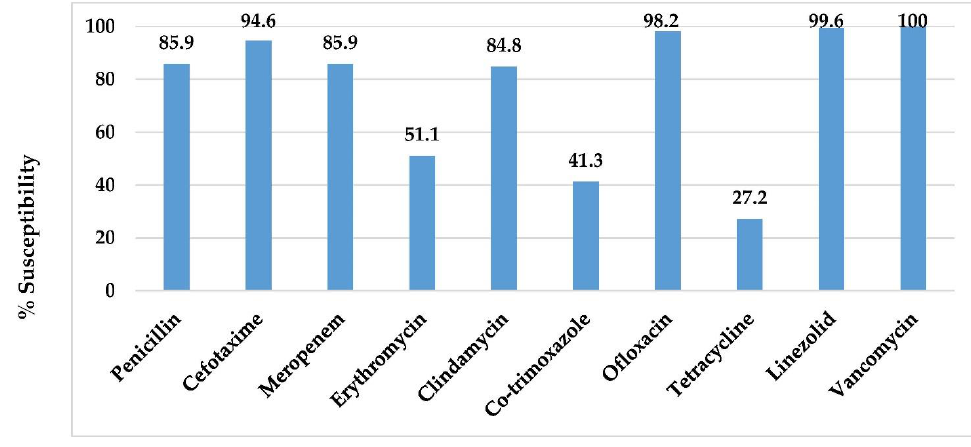
Figure 3. Antimicrobial susceptibilities of pneumococcus-causing IPD in central Thailand, 2012–2016.